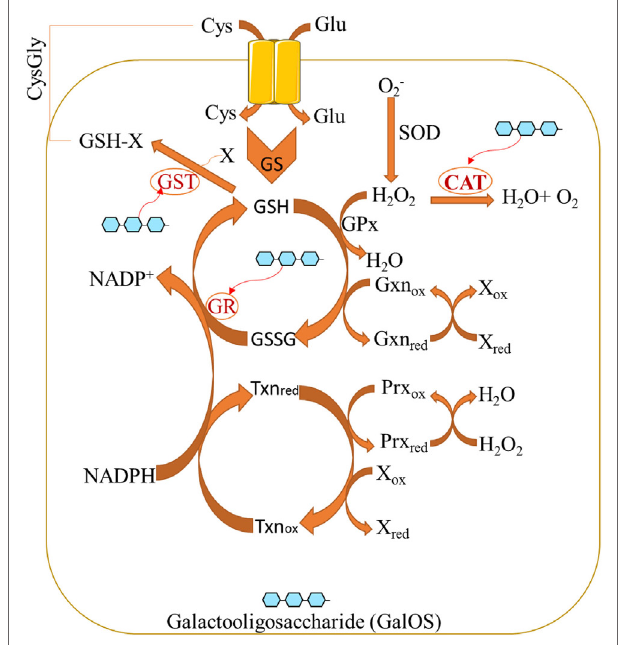
FiguRe 1 | Pectin oligosaccharides regulate cellular antioxidant activities by affecting oxidative stress